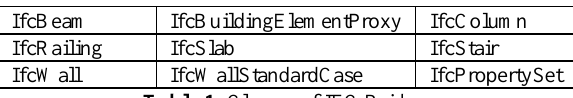
Table 1 . Classes of IFC Bridge.